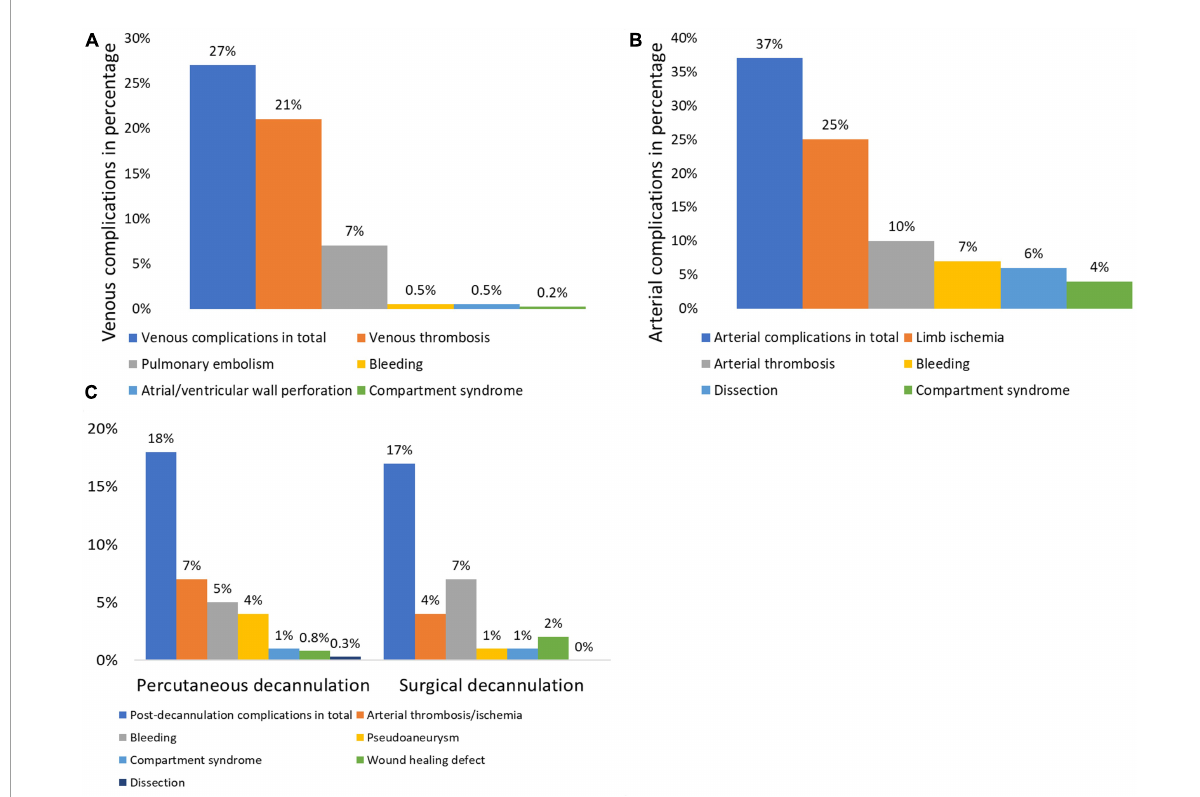
FIGURE2 Prevalences of venous (A) and arterial (B) complications and (C) post-decannulation complications according to the type of decannulation in patients requiring venoarterial extracorporeal membrane oxygenation. Data are presented in percentages. All p -values comparing percutaneous vs. surgical decannulation are >